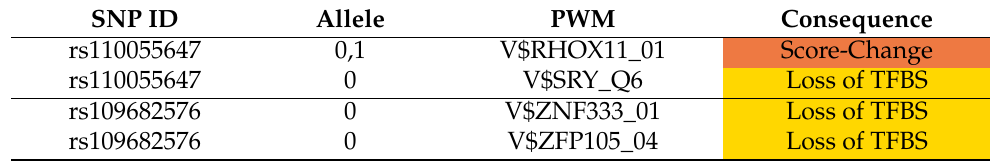
Table 5. Consequences of the SNPs rs110055647 and rs109682576 in the bovine FABP4 upstream promoter with a T to C conversion. Allele 0 refers to a predicted TFBS in the reference sequence, while allele 1 stands for the alternate allele. A SNP causes a loss or gain of TFBS if the considered TFBS is only predicted for the reference or alternate allele, respectively. A SNP is considered to cause a score-change if the TFBS is predicted on both alleles (0,1) with a difference in the matrix similarity score computed by MATCH™